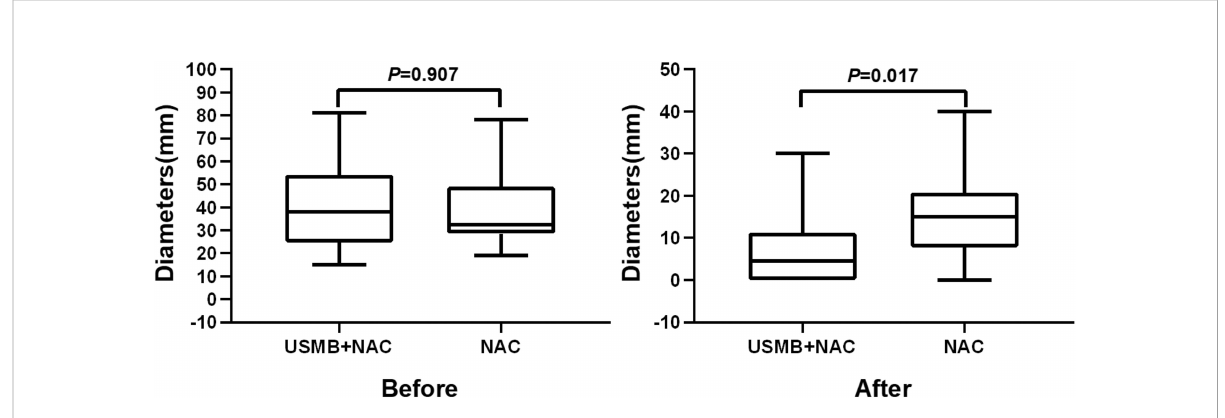
FIGURE 4 Comparison of the maximum diameter of tumors between the two groups before and after neoadjuvant